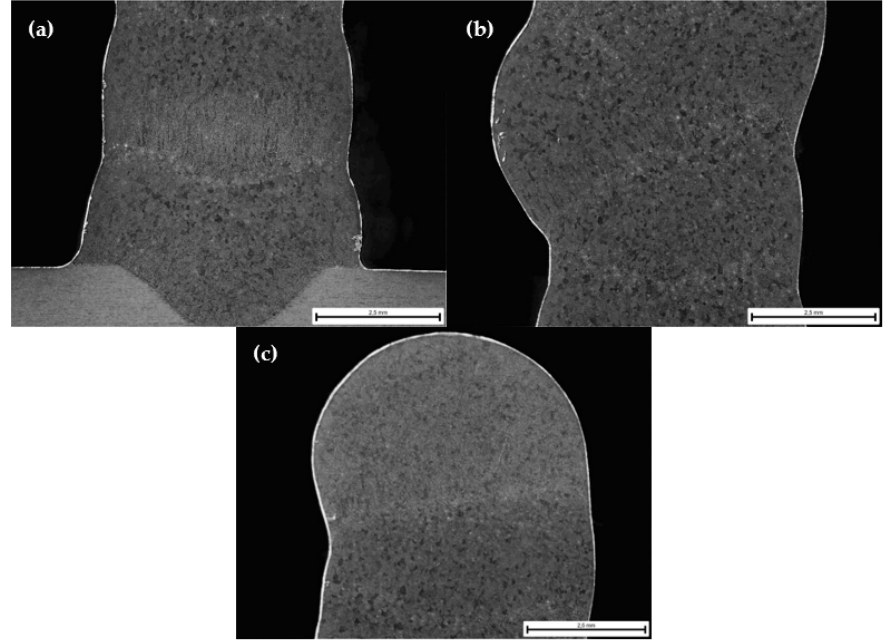
Figure 20. Microstructural structure example of part manufactured with Argon Q1 30 L/min gas flow + hatching ( a ) bottom zone, ( b ) middle zone, and ( c ) top zone.